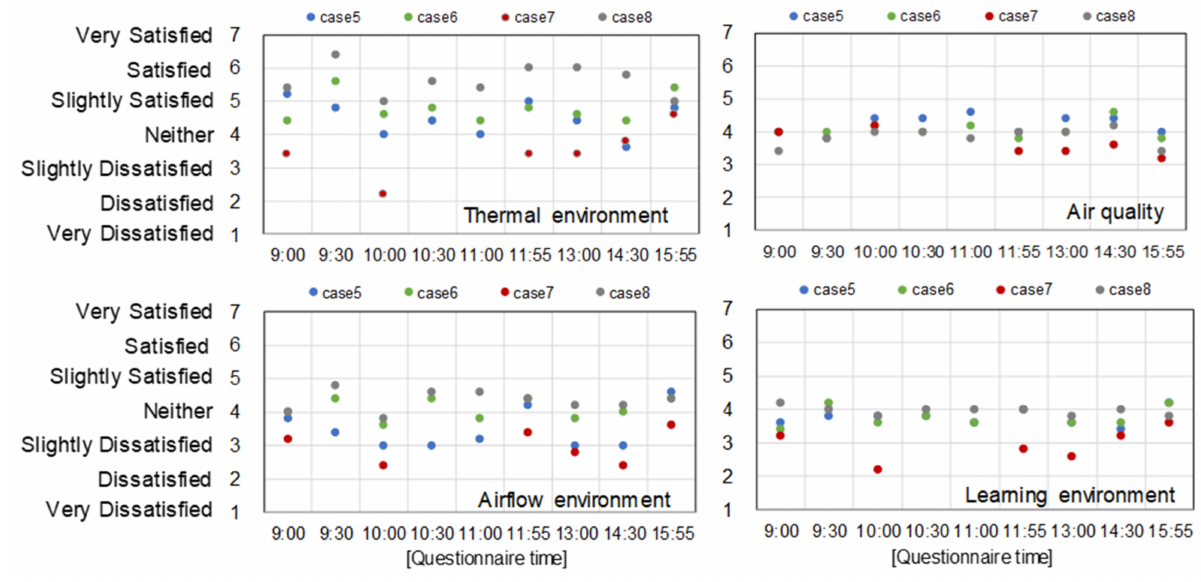
Figure 9. Satisfaction with the indoor environment in winter.